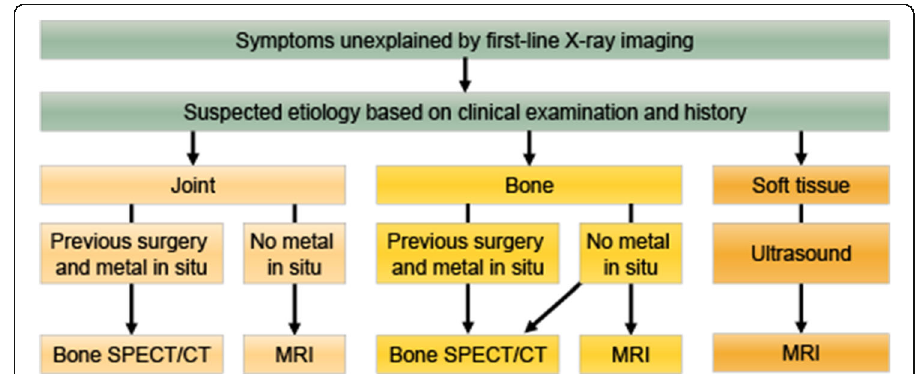
Fig. 1 Imaging algorithm chronic hip pain. Proposed imaging algorithm for chronic hip pain unexplained by clinical examination and history